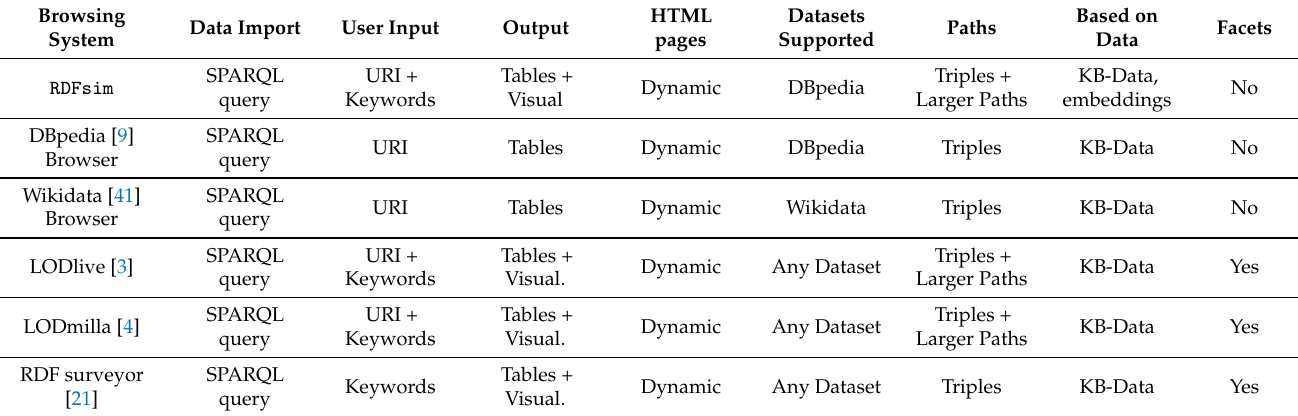
Table 1. Comparison of Browsing